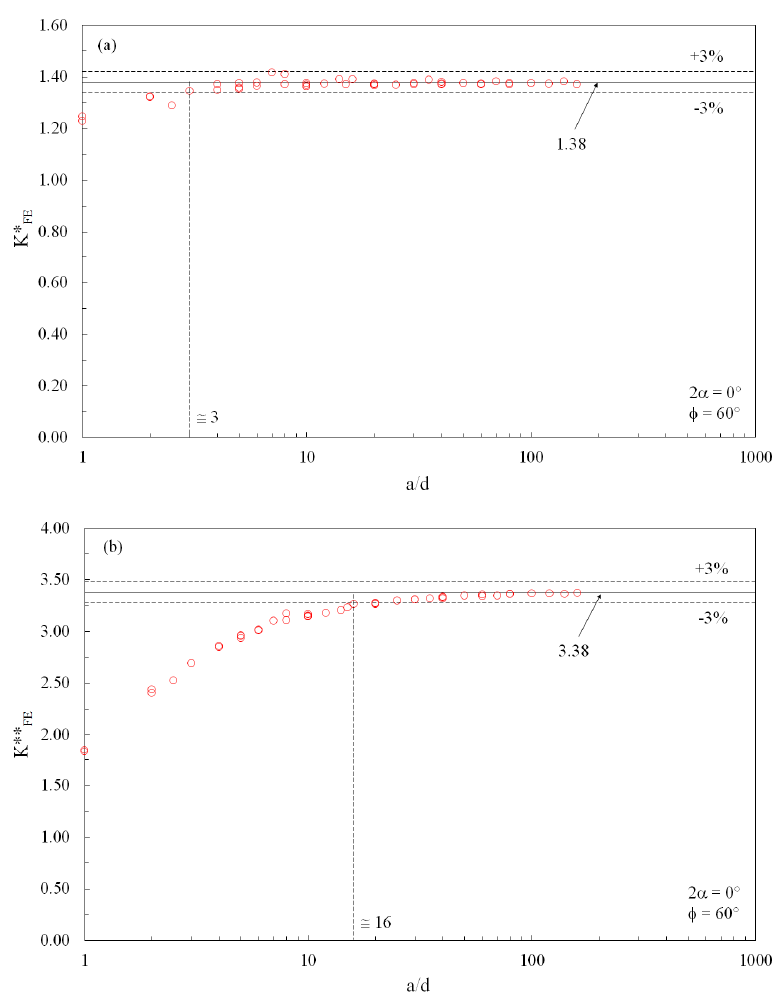
Figure 4: Calibration of the PSM approach for a crack (2 α = 0°) under mixed mode (I+II) loading ( ϕ = 60°). Normalized SIF related to (a) mode I and (b) mode